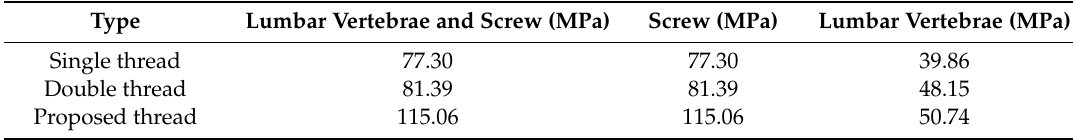
Table 5. FEA analysis